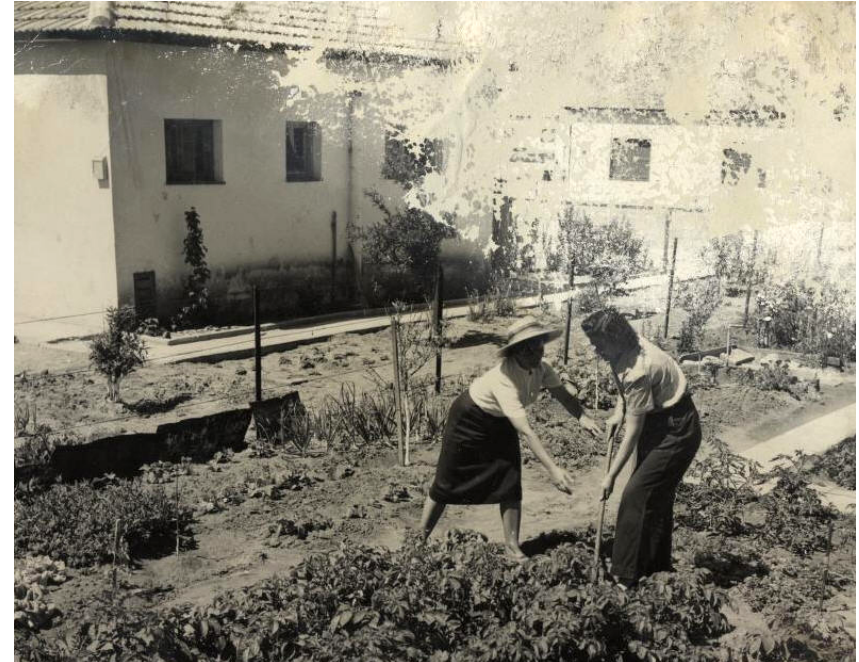
Figure 11. Neighbors’ Neighborhood C. Source: Unknown [ca.